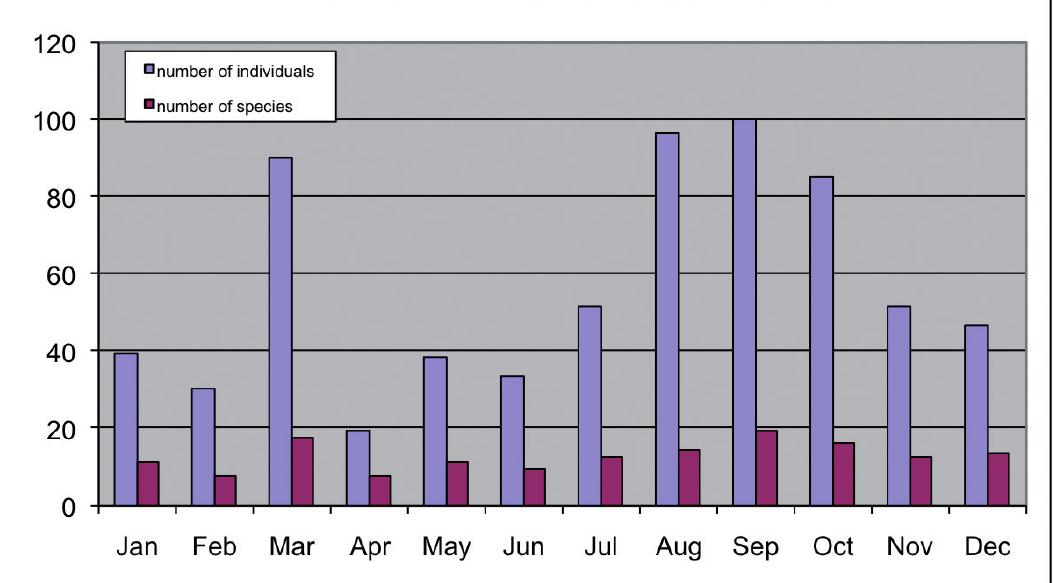
Fig. 236. Activity of Elaphropeza during a year cycle with Malaise traps (March 2005-March 2006) at four sites in Singapore (3 forest and 1 mangrove